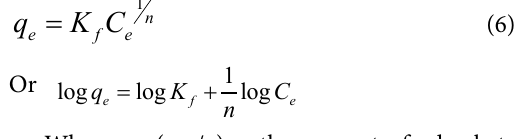
vs log C and (c) Temkin isotherm, plot of q e e